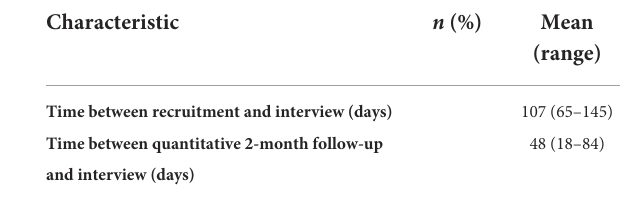
TABLE 1 Participant characteristics (collected in Quitlink trial baseline assessments) ( N =